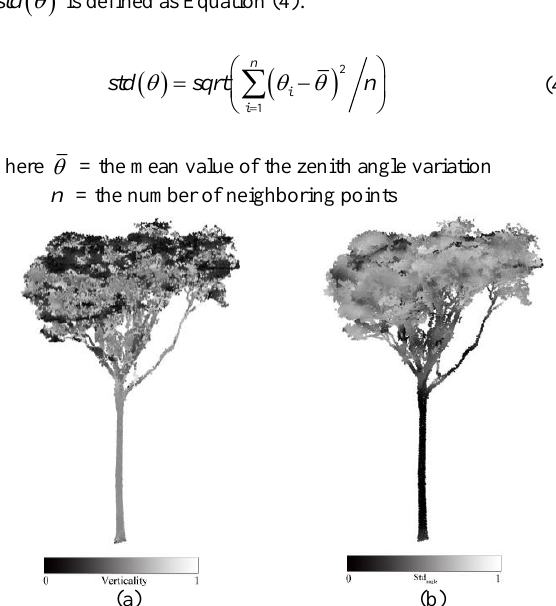
Figure 3. Illustrating the zenith angle and variation for the single tree. (a) zenith angle; (b) zenith angle variation. The color scales at the bottom of each figure indicate the range of angle.